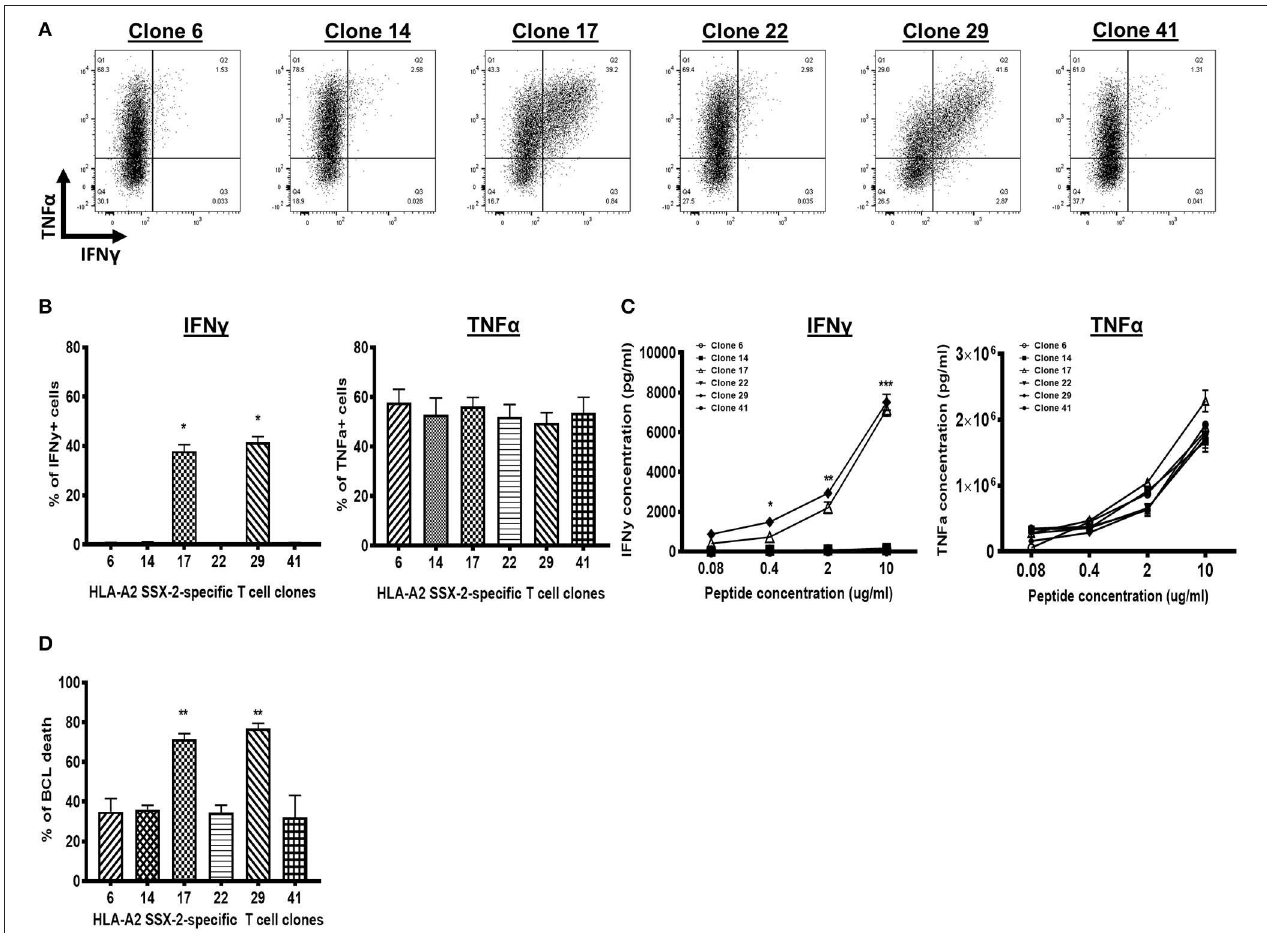
FIGURE 1 | A high frequency of tumor-specific CD8 + T cell clones does not express or secrete interferon gamma (IFN γ ). (A) Flow cytometry dot plots of six synovial sarcoma X (SSX)-2-specific T cell clones. IFN γ is not expressed in four clones (IFN γ − clones: Clones 6, 14, 22, and 41) but is expressed in two clones (IFN γ + clones: Clones 17 and 29). All six clones express TNF α . (B) Proportion of IFN γ + cells (left) or TNF α + cells (right) for each T cell clone, after co-culture with peptide-stimulated lymphoblastoid B cell line (BCL). (C) Level of IFN γ production (left) or TNF α production (right) by each T cell clone, after co-culture with peptide-stimulated BCL. (D) Proportion of BCL cell death following antigen stimulation at 1 µ g/ml and co-culture with each T cell clone. N , number of experimental repeats = 3. * P < 0.05, ** P < 0.01, *** P < 0.001; analysis performed with one-way ANOVA with Tukey’s multiple comparison